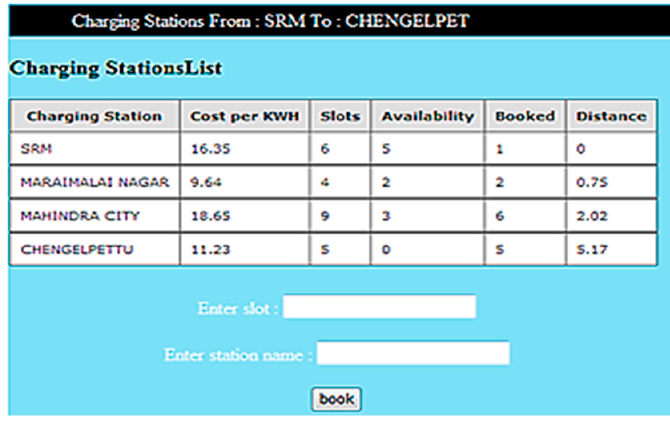
Figure 12. Charging station reservation.